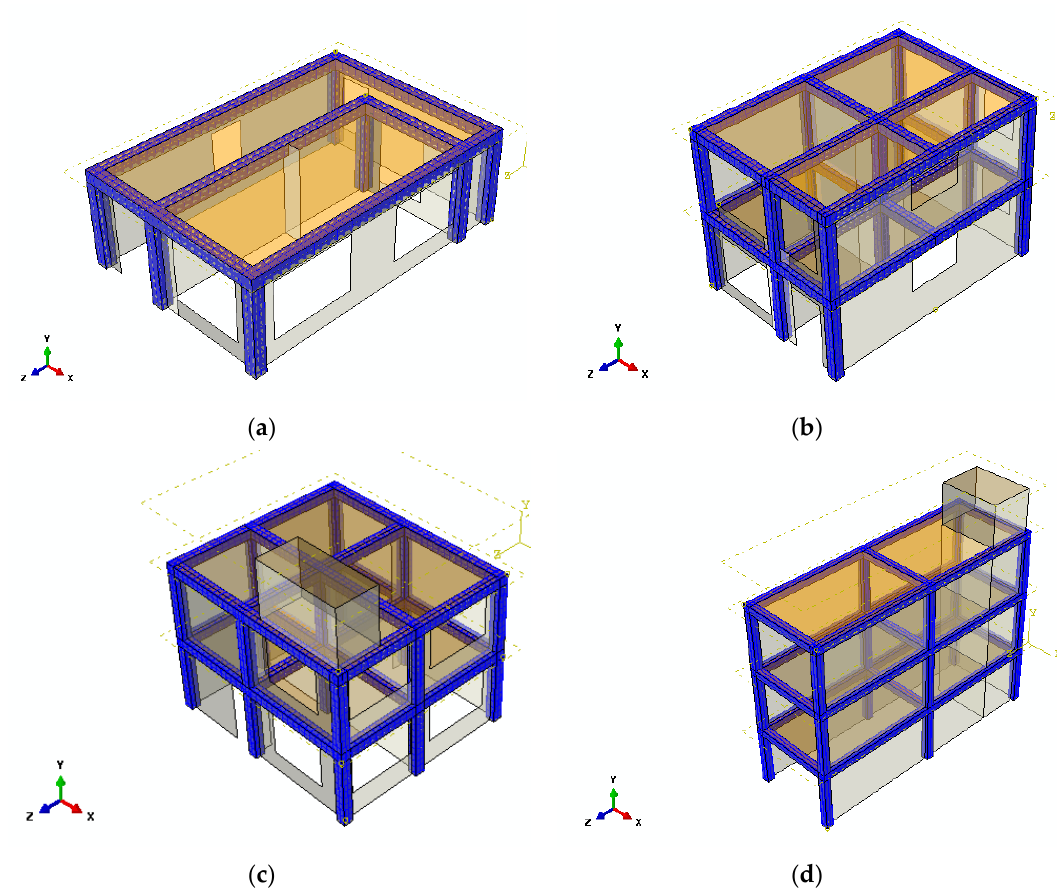
Figure 6. Location of the horizontal and vertical RC ties in CM model buildings (shown in blue): ( a ) Type-1 model building (single-story); ( b ) Type-2 model building (two-story); ( c ) Type-3 model building (two-story); ( d ) Type-4 model building (three-story).